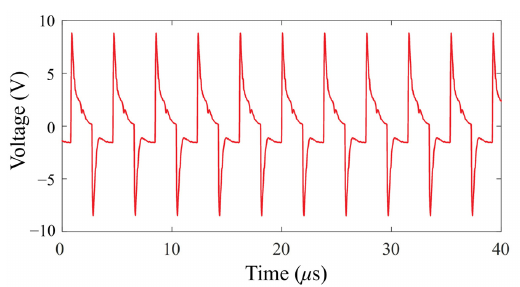
Figure 19. PV module diode-bypass failures .